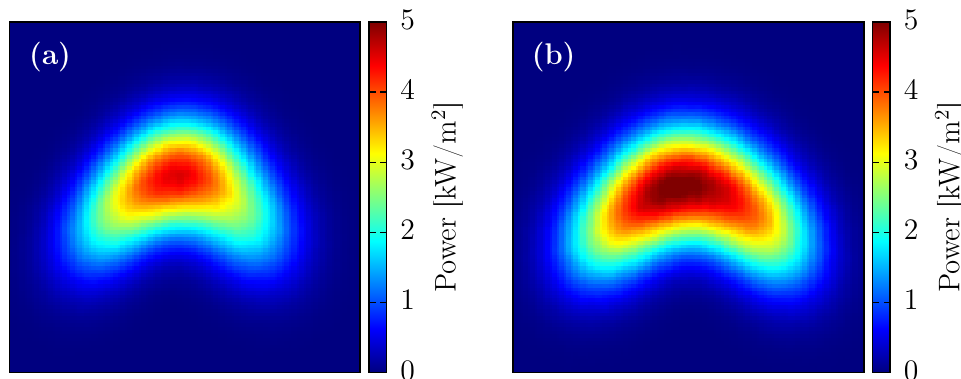
Figure 9. Concentrated solar flux distribution on the receiver (6m × 6m) for an H32 array, on 21 June at 8:30 ( a ) and 12:30 ( b ), solar time, for a distance of 2 h (70